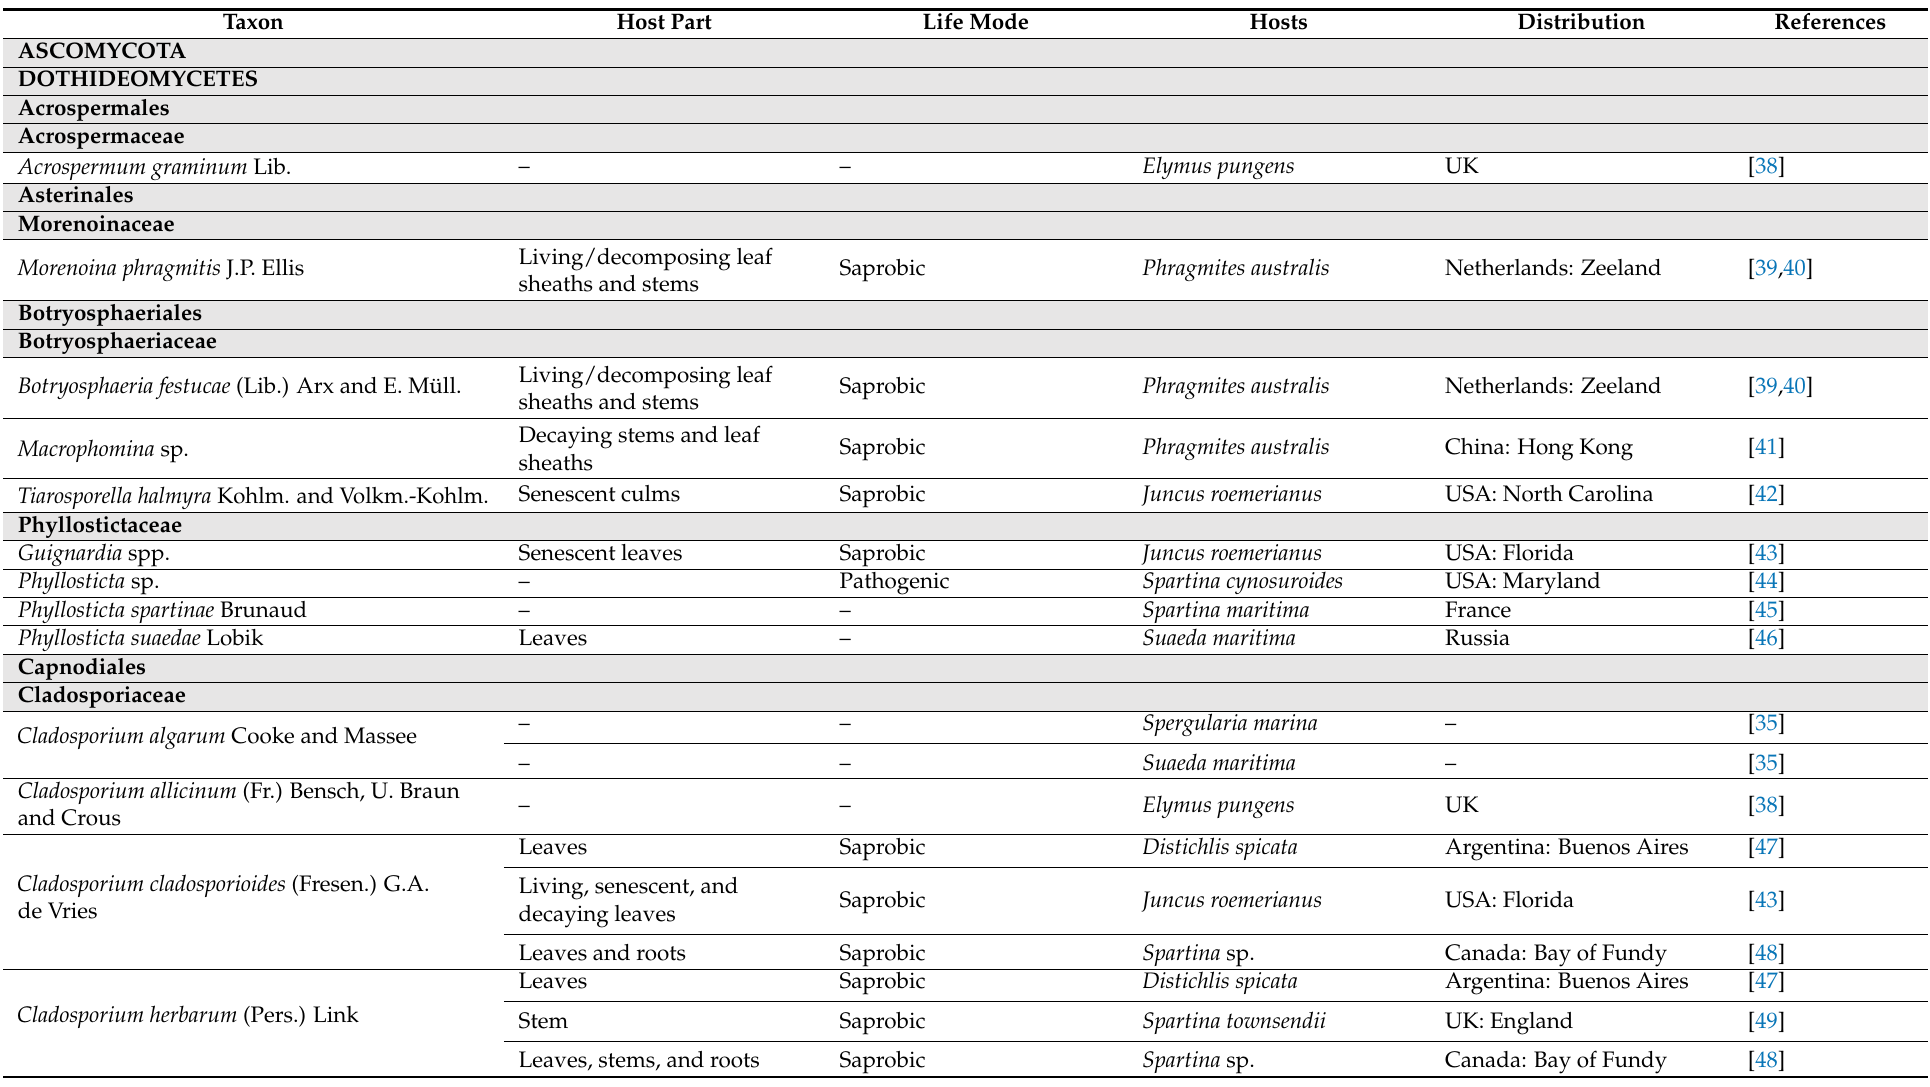
Table 1. Geographical distribution of salt marsh fungi recorded from various